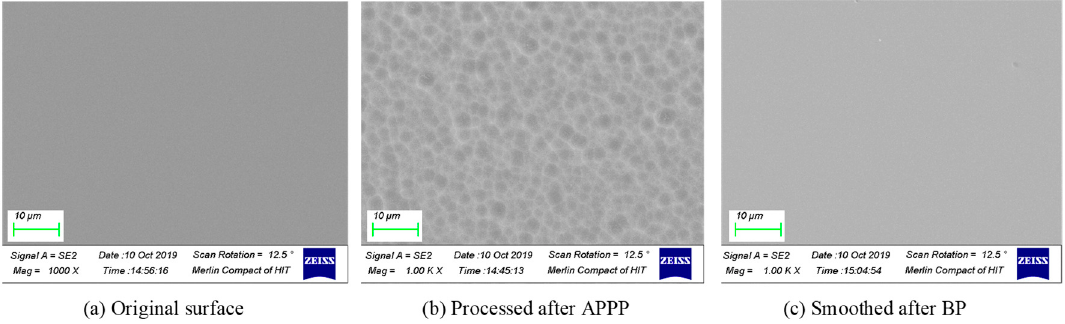
Figure 12. SEM images on different substrate surfaces. ( a ) Original surface; ( b ) Processed after APPP and ( c ) Smoothed after BP.